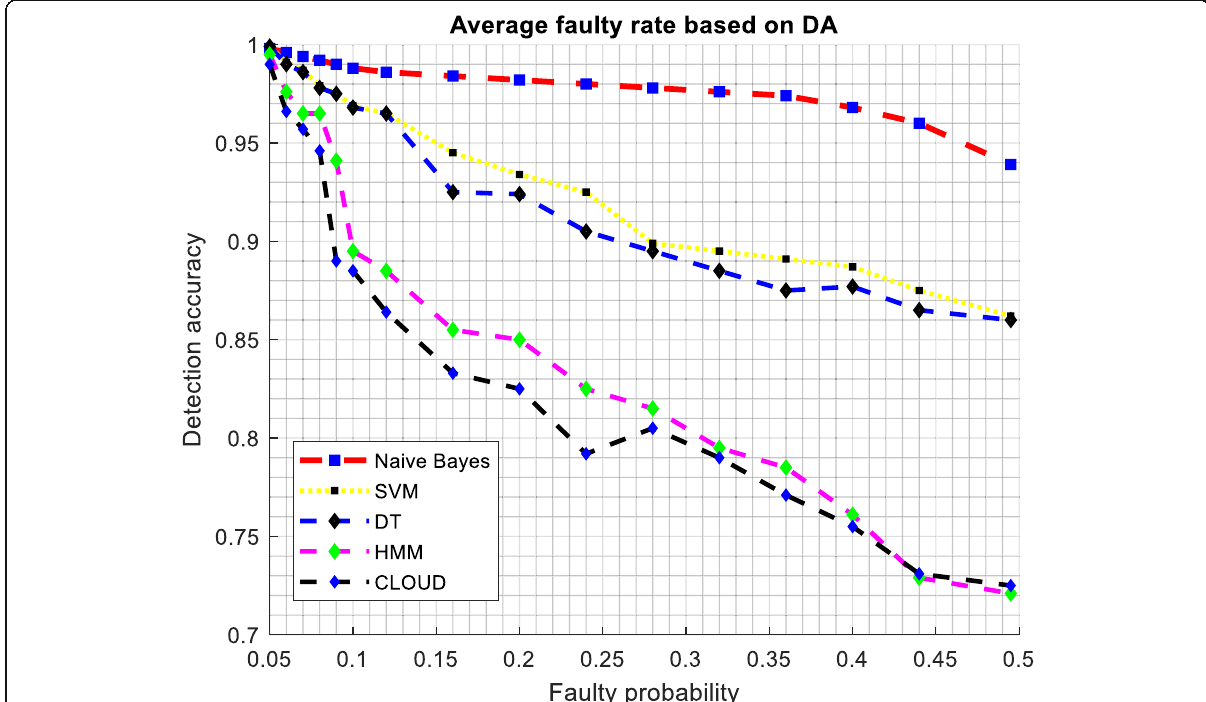
Fig. 8 Comparison of the proposed method for the classification of collecting data with the SVM [26], DT [36], HMM [38] and the CLOUD [33] on the hardware